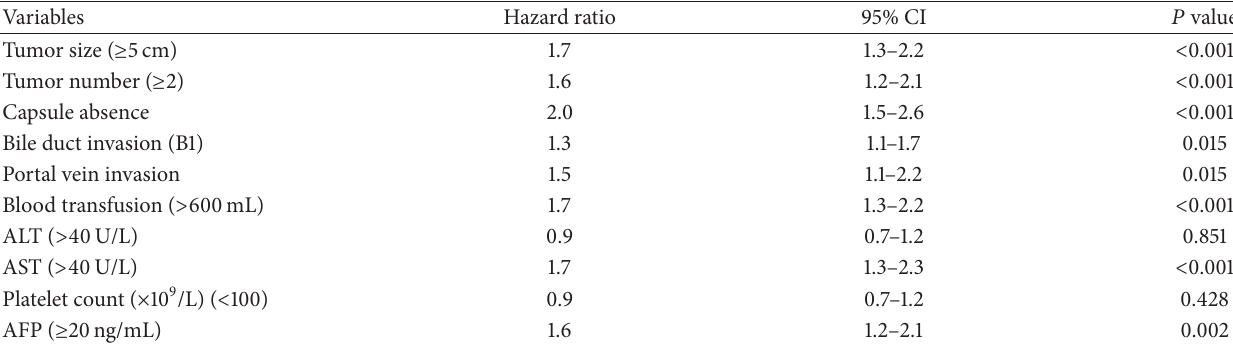
Table 4: Multivariate analysis of risk factors for prognosis of HCC after surgical